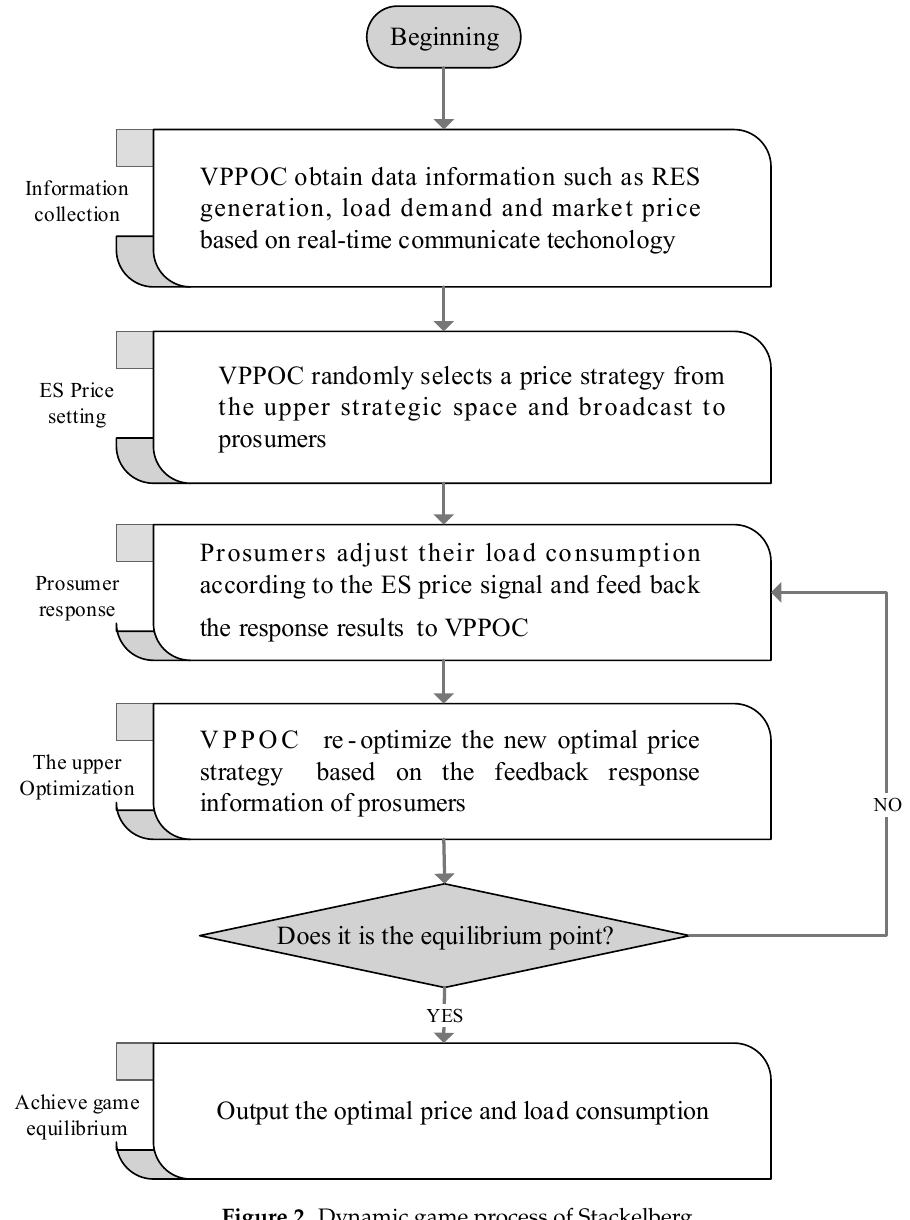
Figure 2. Dynamic game process of Stackelberg.